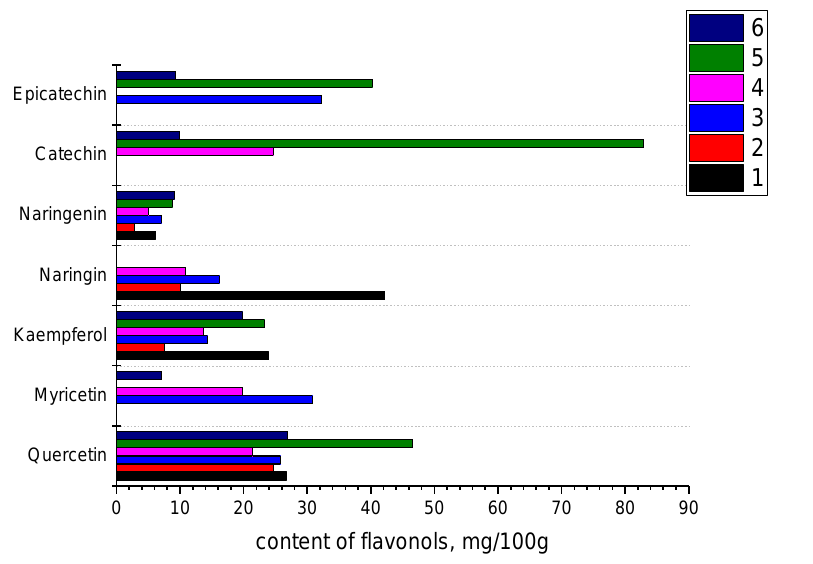
Figure 3. Content of flavonoids determined by HPLC method, mg/100 g. 1. A. platensis (convection dried); 2. A. platensis (lyophilized); 3. U. intestinalis ; 4. C. linum ; 5. E. crinita ; 6. Chlorella spp. E. crinita had the highest content of quercetin, catechin, and epicatechin (Figure 3). Quercetin-3- β -glycoside and catechin were not detected in U. intestinalis , but it possessed the highest levels of myricetin (30.82 mg/100 g) compared to other species examined. E. crinita did not contain myricetin. Catechin and epicatechin were not detected in both A. platensis samples. The lyophilization process of A. platensis did not affect the content of quercetin but led to a decrease in the values of quercetin-3- β -glycoside, kaempferol, narginine, and naringenin of nearly three times (Figure 3).